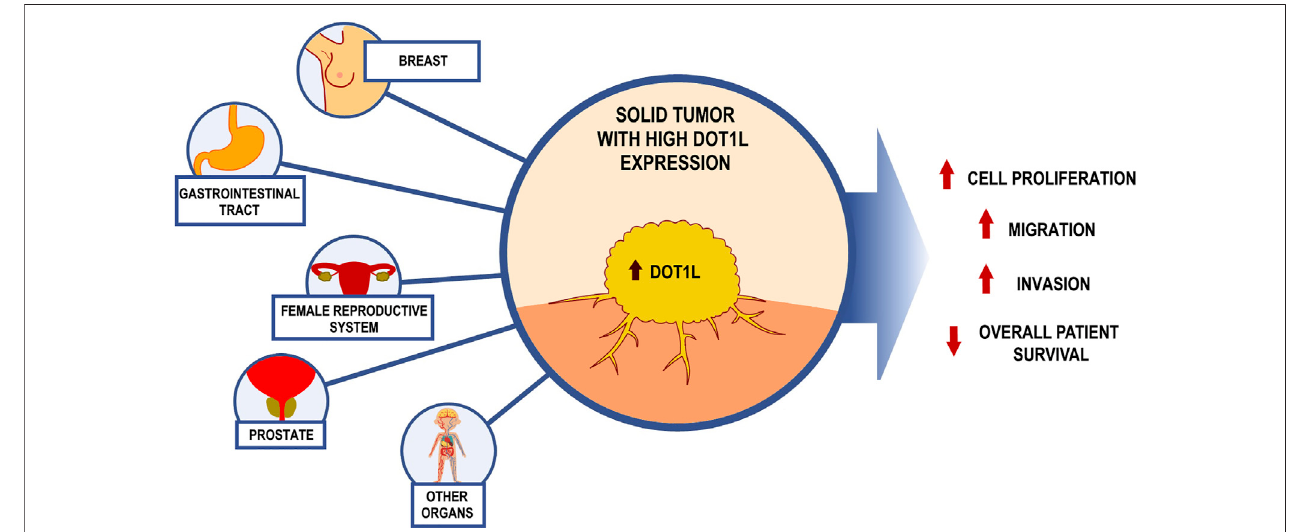
FIGURE 1 | Consequences of excessive DOT1L levels on the malignant phenotype of solid